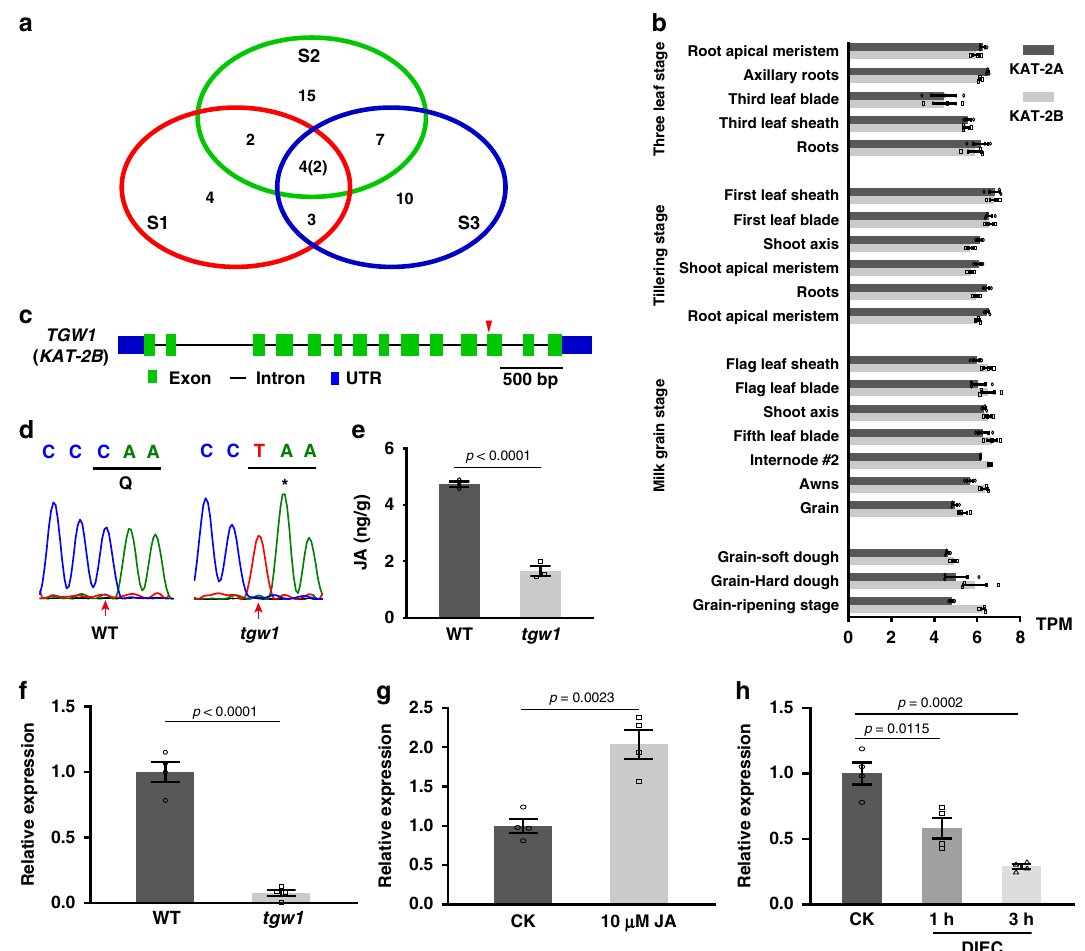
Fig. 2 Molecular cloning of TGW1 . a Venn diagram to show distributions of homozygous SNPs in three groups of homozygous BC 1 F 2 mutants. S1 to S3 represented three groups of homozygous BC 1 F 2 mutants. Each number represents numbers of homozygous SNPs. Only two nonsynonymous homozygous SNPs presented in three groups. b The expression of KAT-2B (TraesCS6B01G432600) and KAT-2A (TraesCS6A01G392400) in different tissues at various developmental stages. n = 3 independent replicates. c Genomic structure of TGW1 ( KAT-2B ) gene. The red triangle points to the position of the point mutation in tgw1 . d Veri fi cation of the SNP in the KAT-2B ( TGW1 ) gene in WT and tgw1 by sequencing. e Contents of JA in leaves of WT and tgw1 . n = 3. f Relative expression level of Cell Number Regulator 6 ( CNR6 ) in WT and tgw1 mutant. n = 4. g The expression level of CNR6 upon 10 μ M JA treatments in WT. n = 4. h The expression level of CNR6 upon 200 μ M JA inhibitor DIEC treatments in WT. n = 4. Data are represented as mean ± SEM in b , and e – h . p values are indicated by two-tailed unpaired t test in e – h . Source data underlying Figs. 2a, b, e – h are provided as a Source Data fi